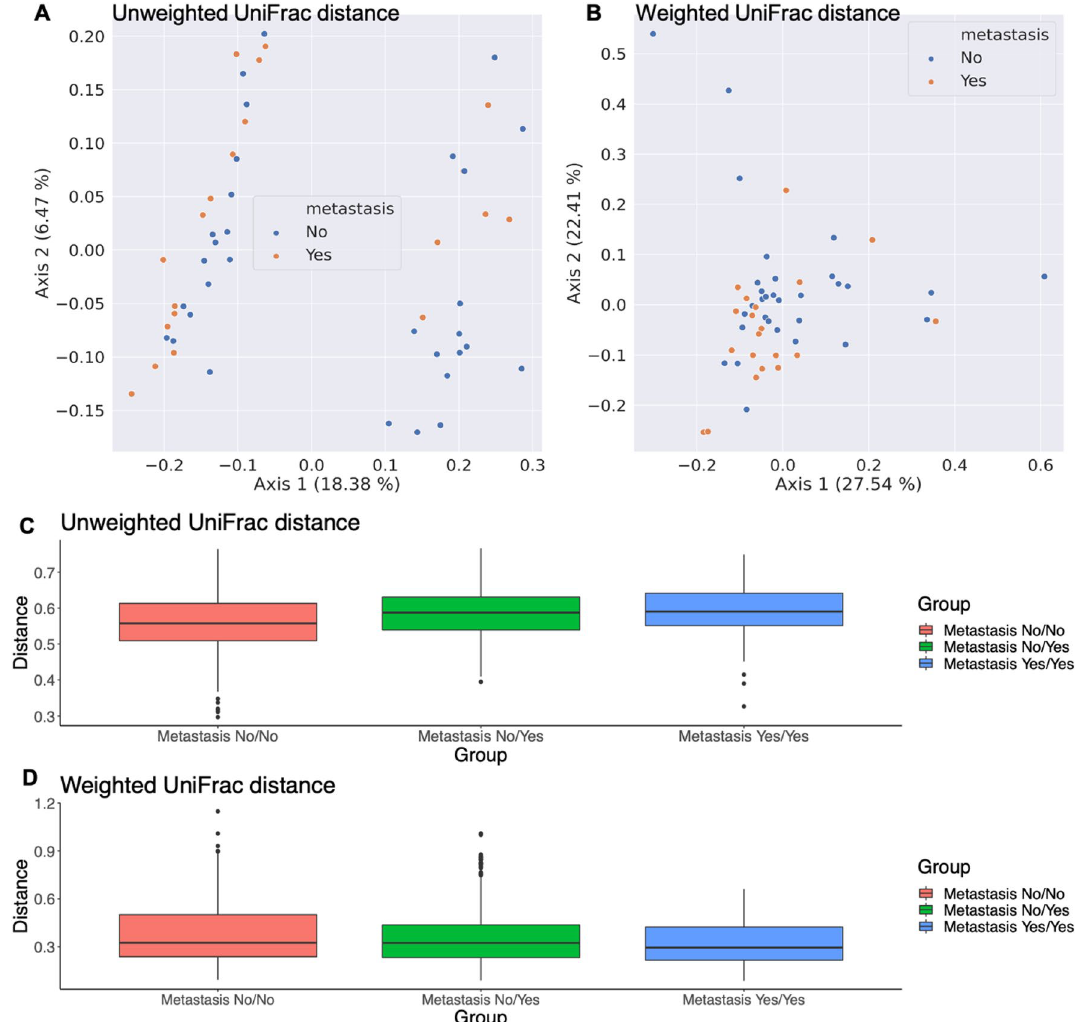
Figure 2. β-diversity in oral squamous cell carcinoma patients with metastasis and no metastasis. Principal coordinated analysis of unweighted ( A ) and weighted ( B ) unifrac distance of oral microbiota. Each point represents individual sample. Average unweighted ( C ) and weighted ( D ) unifrac distance representing intragroup and intergroup within oral microbiota. Permutational multivariate analysis of variance was performed with the unweighted unifrac distance index (Permanova p = 0.031) and weighted unifrac distance index (Permanova p = 0.069). Metastasis yes/yes in X axis means the sequence distance between one sample in the yes group and another sample in the yes group.